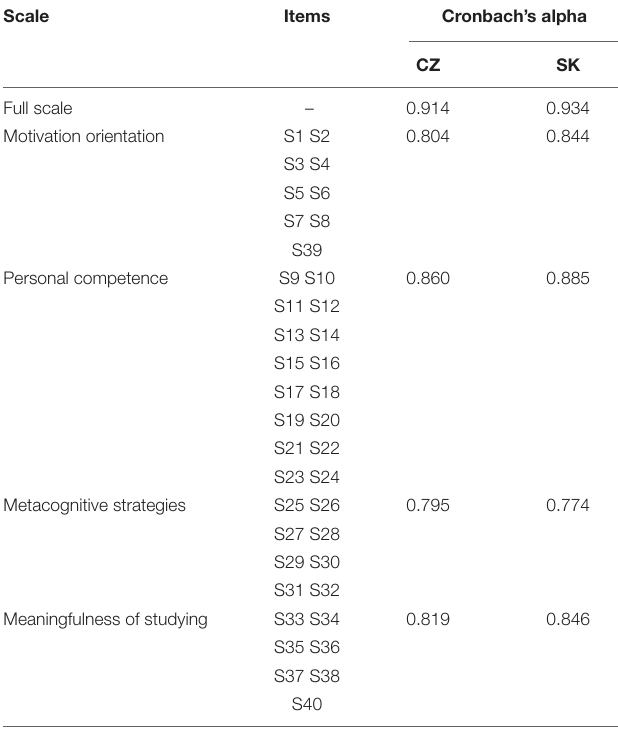
TABLE 3 | Final classification of statements into scales and reliability of scales.